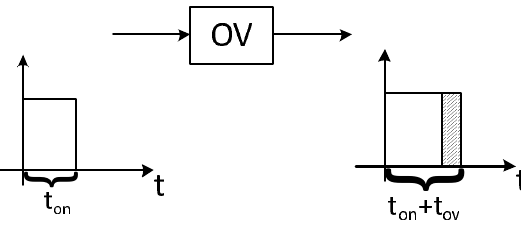
Figure 3. Overlap time insertion. c (cid:13) 2016 IEEE